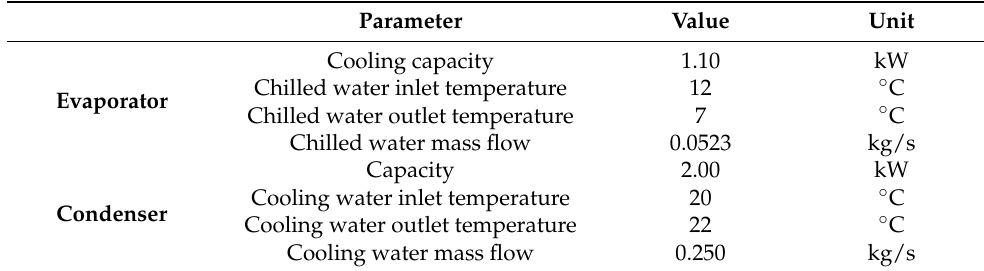
Table 2. Main parameters of the adsorption chiller with desalination function installed at the Energy Centre of the AGH University of Science and Technology.